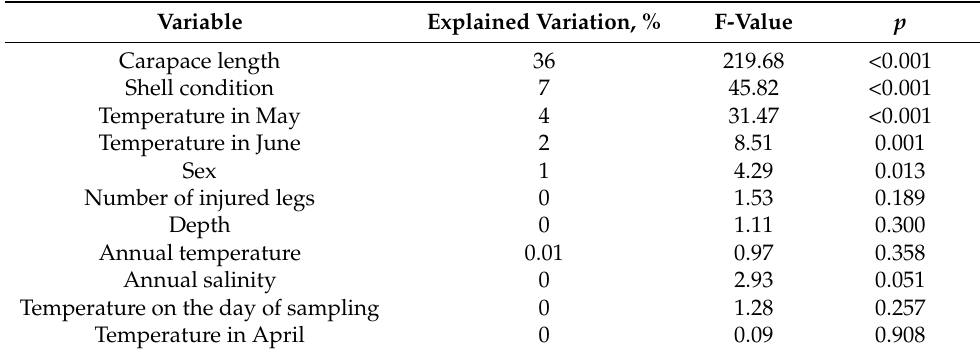
Table 2. List of environmental variables influencing mean intensities of epibiotic species on red king crabs collected in Dalnezelenetskaya Bay in summers during the period 2009–2013 (Monte-Carlo permutation test in RDA).